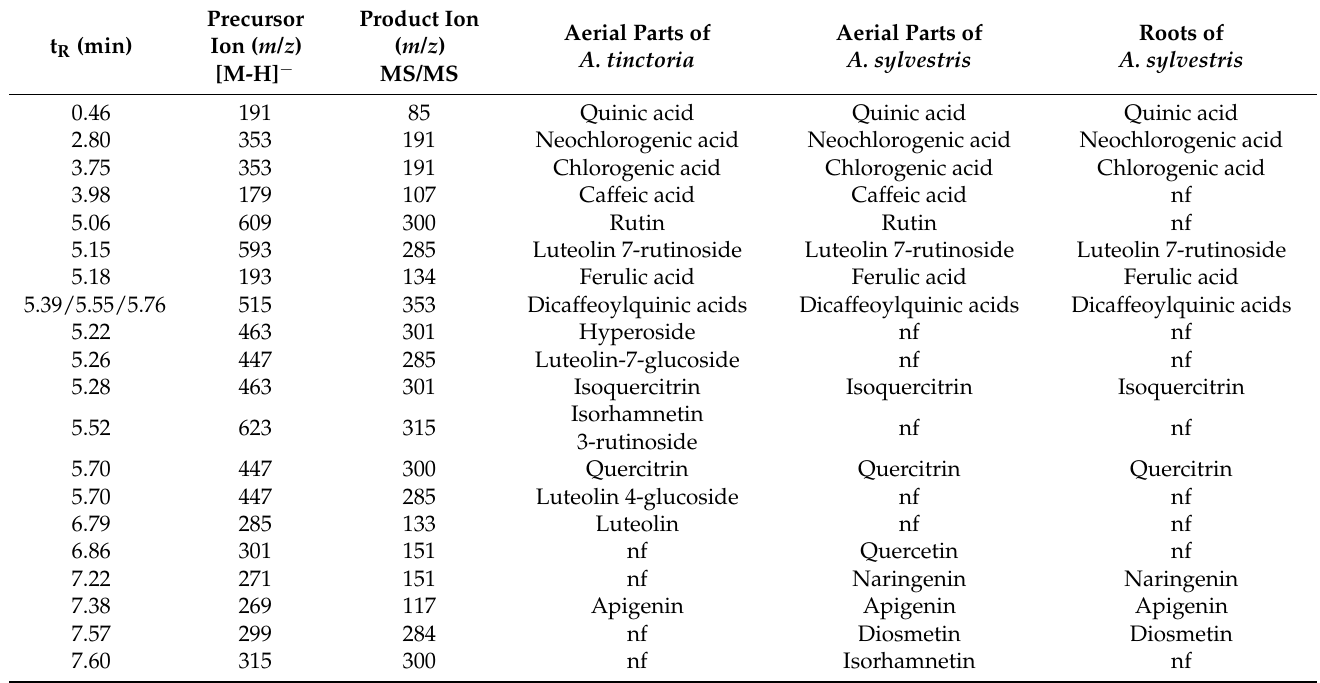
Table 4. Polyphenolic compounds identified in the methanolic extract of A. tinctoria and A. sylvestris by the UPLC–triple quadrupole MS/MS (MRM) method.